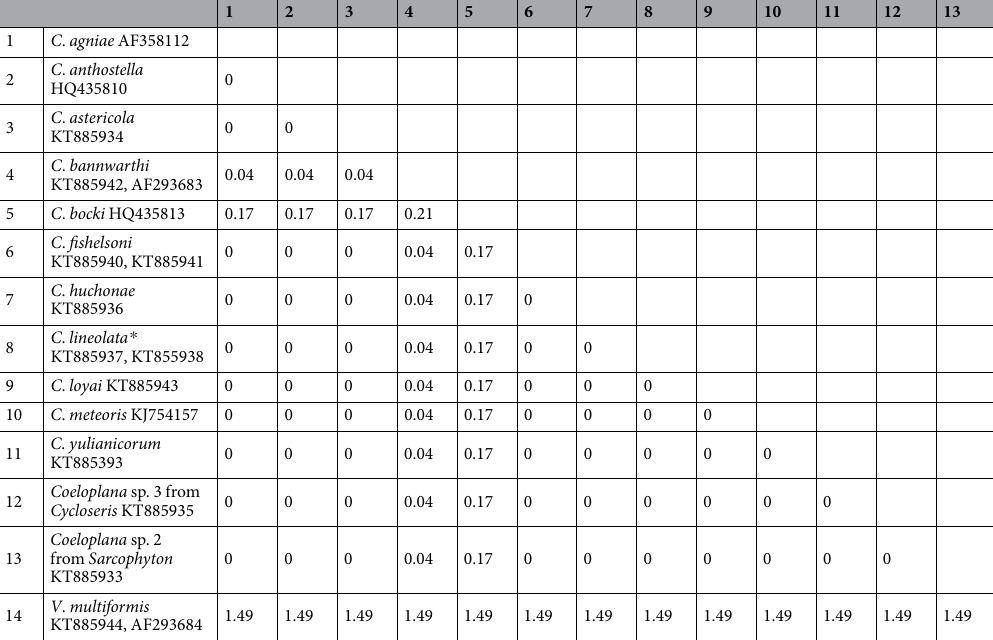
Table 1. 18S rDNA interspecific sequence divergences ( p -distances) of ctenophore species from the family Coeloplanidae. Each species is represented by a single sequence, except C . bannwarthi , C . fishelsoni , C . lineolata and V . multiformis , which are represented by two individuals each. * C . lineolata and C. punctata were considered to belong to the same